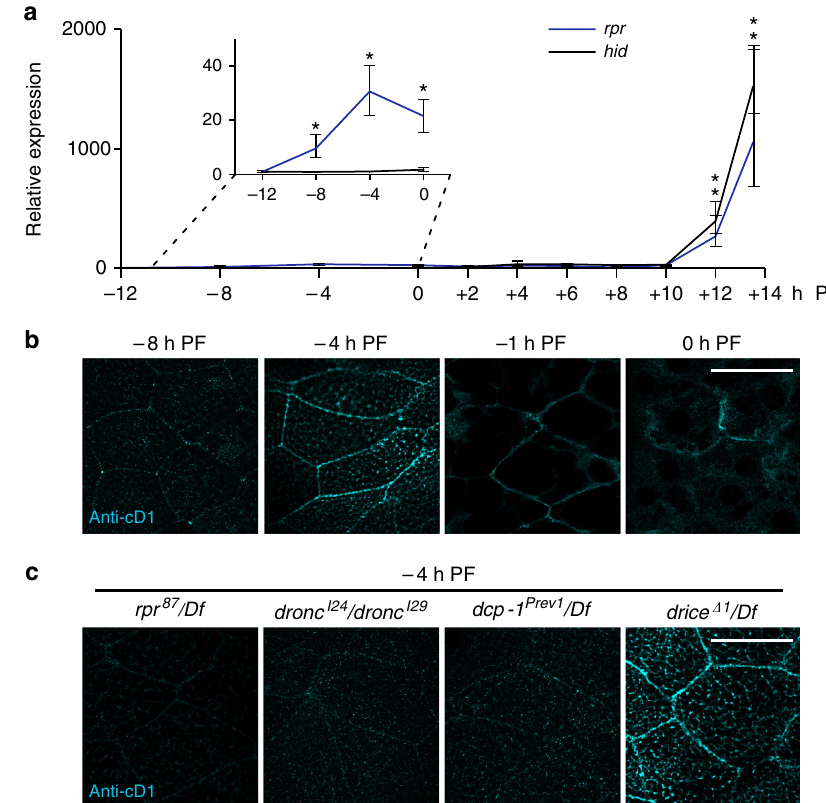
Fig. 1 A low amplitude pulse of reaper ( rpr ) triggers caspase activation at the cortex of salivary glands. a qPCR analysis of rpr ( blue line ) and head involution defective ( hid ) ( black line ) expression in salivary glands at the onset of metamorphosis. Both rpr and hid are induced > 1000-fold at the start of pupal development, while only rpr is induced (~ 30-fold) at the end of larval development. y- axis shows relative expression; x- axis shows developmental stage in hours relative to the onset of metamorphosis. Expression levels shown relative to the lowest point for each gene and normalized to the reference gene rp49 . Three biological samples analyzed for each stage; error bars represent standard error determined by REST analysis (see “ Methods ” ); asterisks indicate p- value < 0.05 calculated by REST analysis. b Timecourse of cleaved-Dcp1 (anti-cD1) antibody staining in salivary glands at the end of larval development. Anti-cD1, in cyan , does not exhibit speci fi c staining at − 8 h PF, but stains strongly at the cortex at − 4 h PF. Cortical staining of cD1 persists through − 1 h PF, but diminishes at 0 h PF. c Regulation of anti-cD1 cortical staining in salivary glands at − 4 h PF. Cortical cD1 staining is absent in rpr , dronc , and dcp-1 mutant salivary glands, but present in drice mutant salivary glands. Scale bars represent 100 µ m. PF, puparium formation, Df, de fi